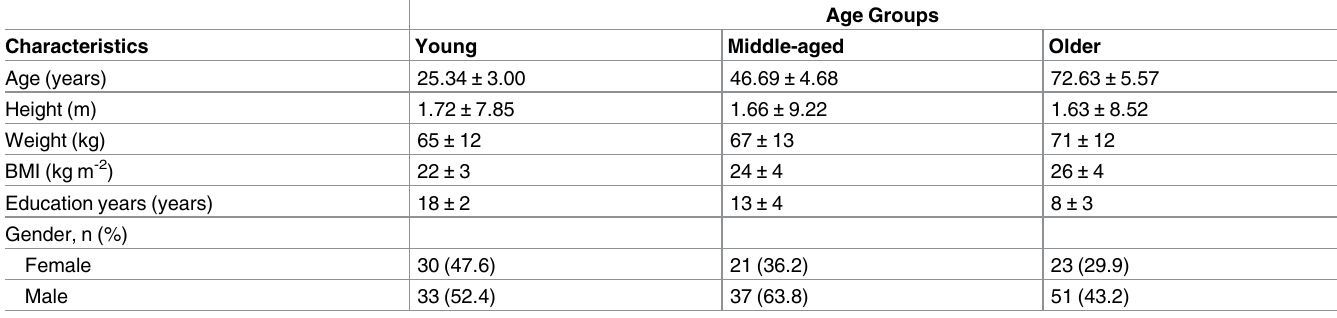
Table 1. Socio-demographic characteristics of